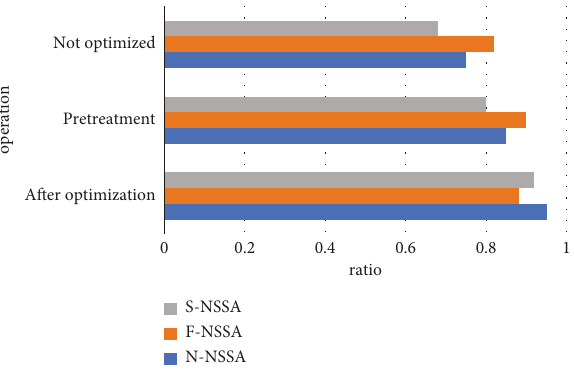
Figure 7: Comparison of detection rates of three models.